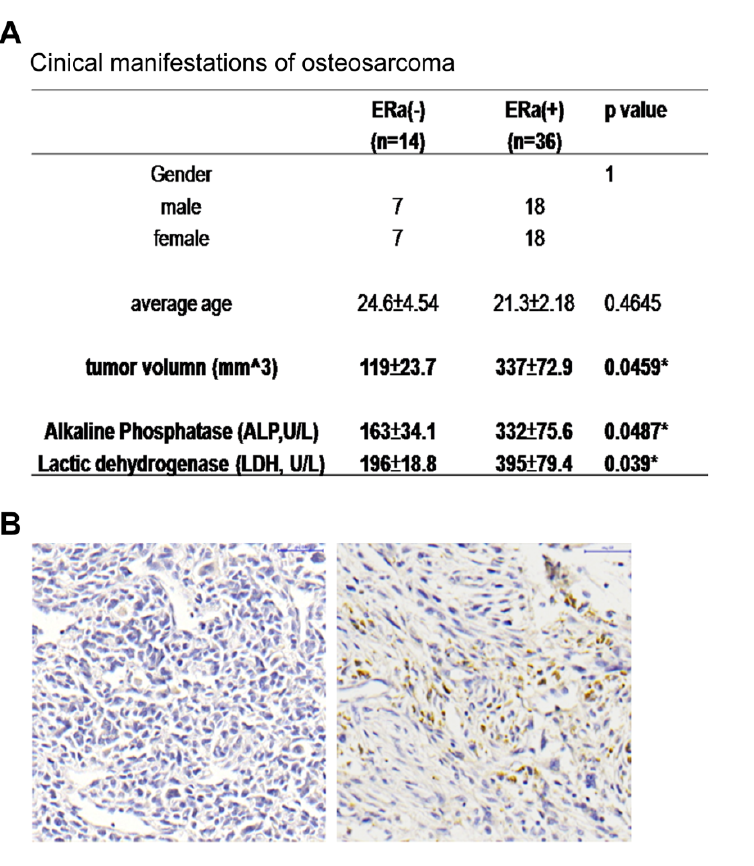
Figure 1. ER α positive expression pattern in OS patients was correlated with increased tumor sizes and ALP and LDH levels. ( A ) The enrolled patients’ information; ER(+) subjects showed larger tumor sizes and higher ALP and LDH levels. ( B ) The immunostaining of ER α on OS sections showed positive brown color. * p < 0.05.